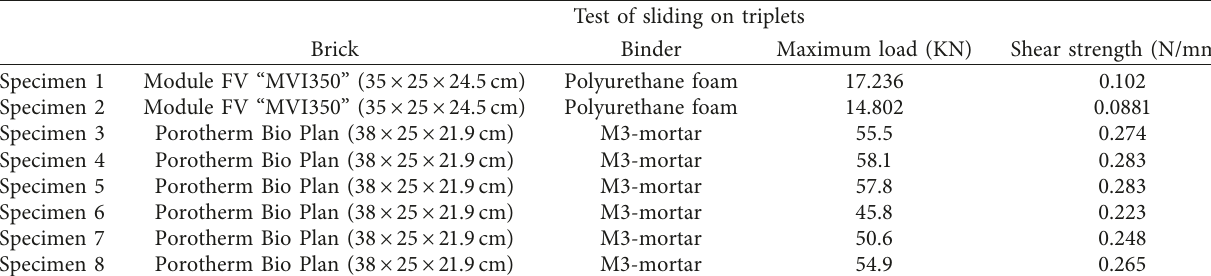
Table 6: Results of the sliding on triplet tests.